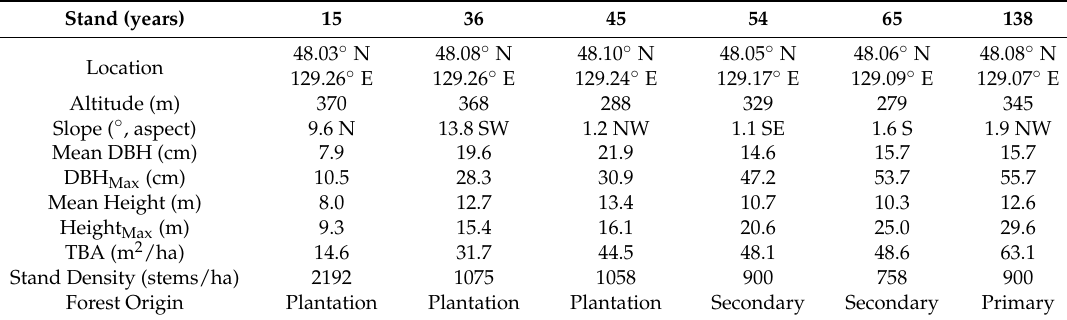
Table 1. Stand characteristics of the six Larix gmelinii